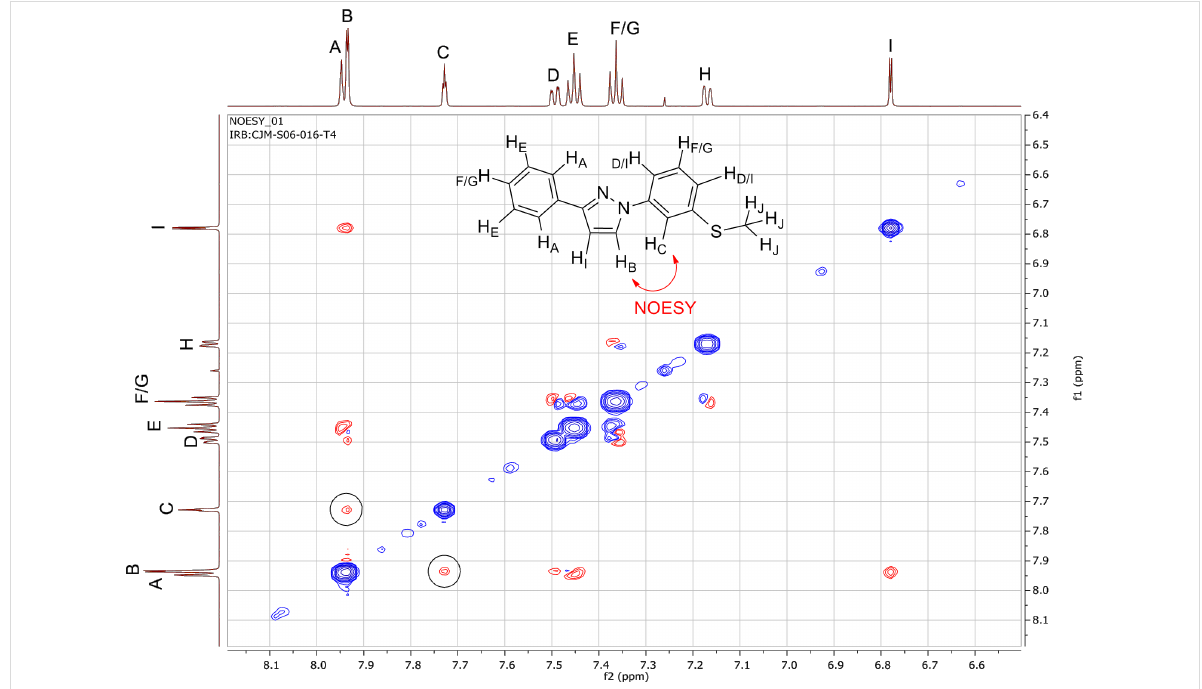
Figure 4: NOESY NMR spectrum for 30 with the characteristic NOESY signal encircled.